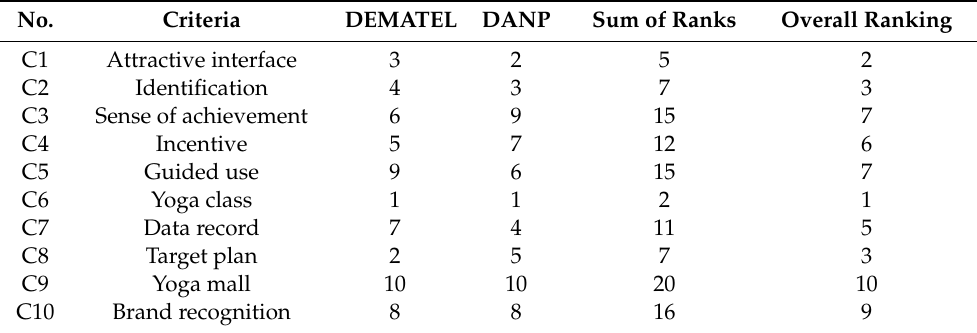
Table 6. The overall ranking of the